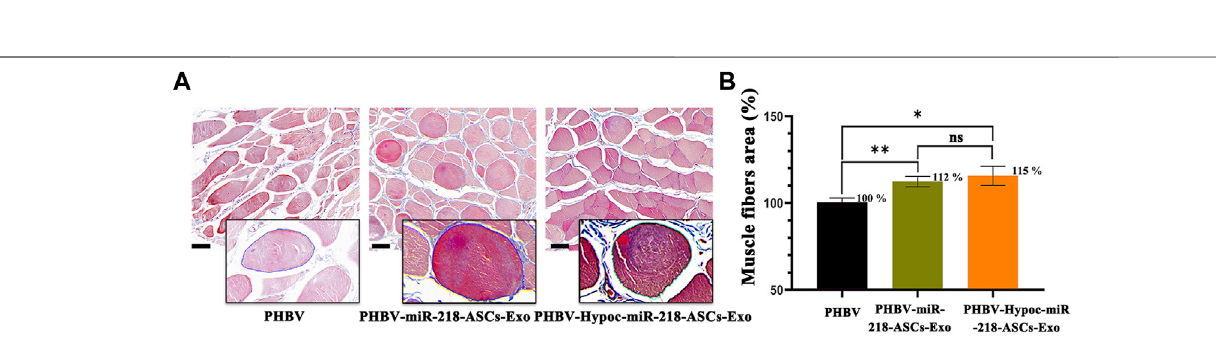
Frontiers in Bioengineering and Biotechnology |